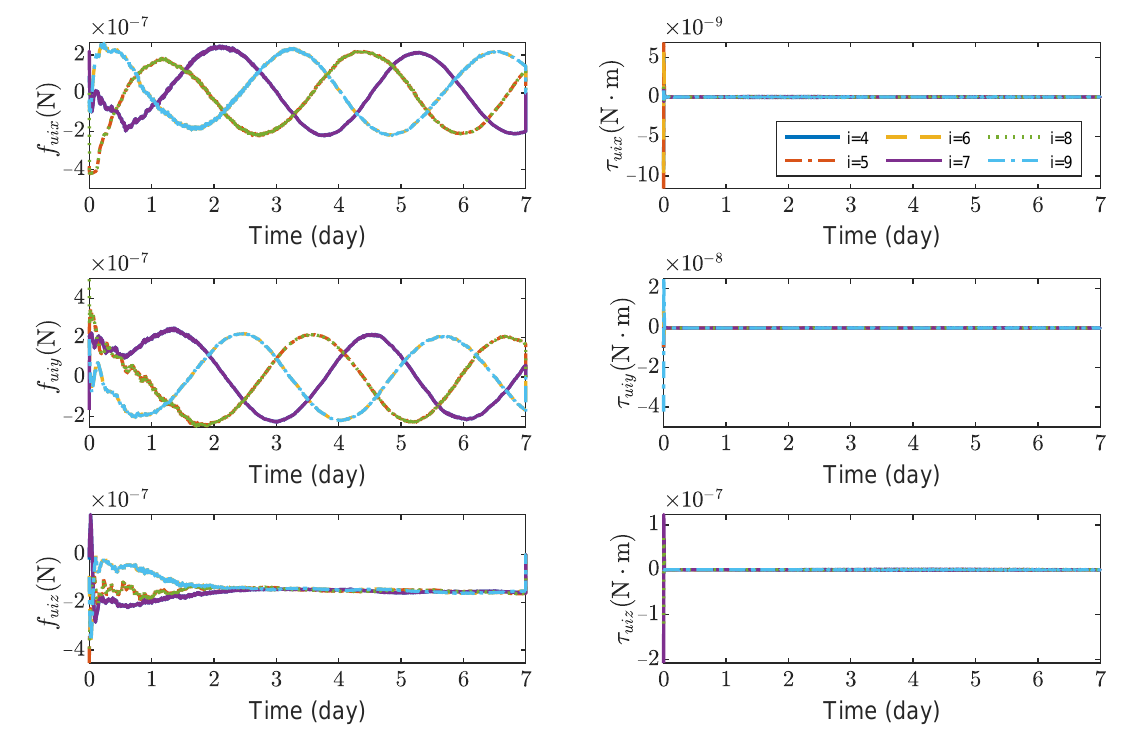
Figure 12. Control forces and control torques of TM1 ∼ 6, the max control force of spacecraft is 100 µ